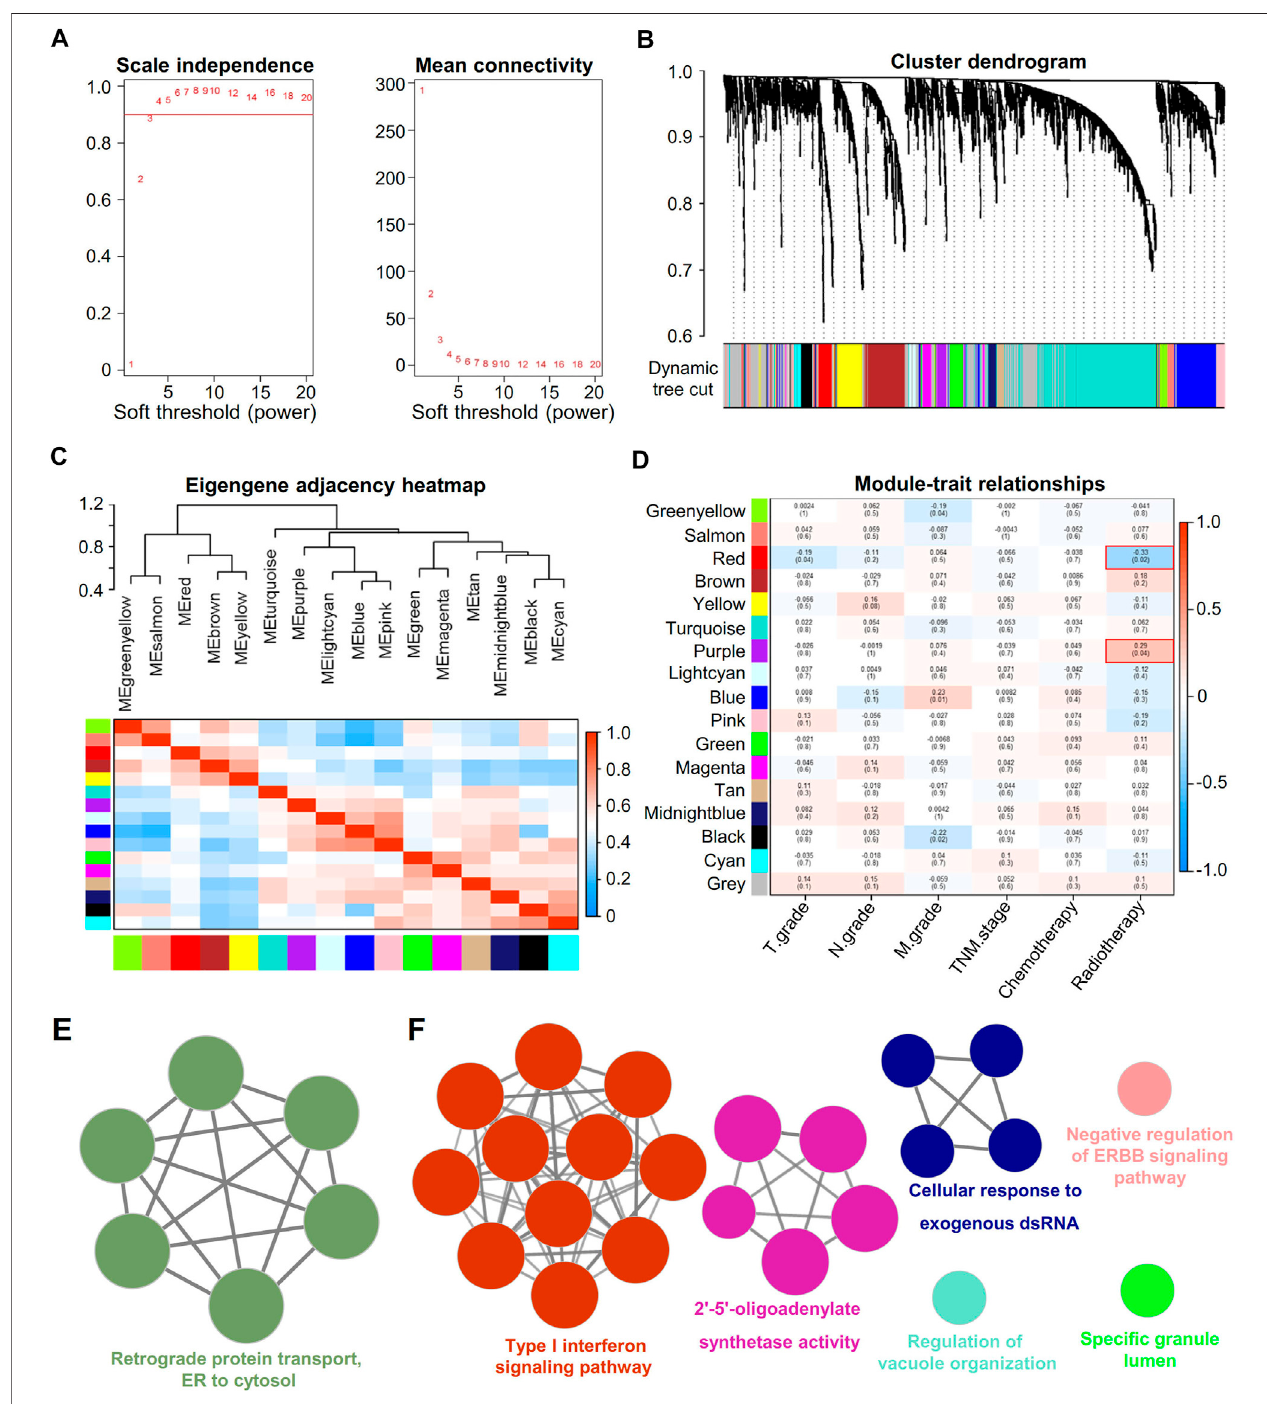
FIGURE 3 | Identi fi cation of key modules correlated with clinical traits in the TCGA-LUAD dataset with WGCNA and ClueGO. (A) Soft thresholding for WGCNA analysis. (B) Clustering dendrogram of genes based on topological overlap. (C) Clustering of module eigengenes. The heatmap shows the correlation of the adjacency module. (D) Heatmap of the correlation between module eigengenes and clinical traits of RT. (E) Enrichment analysis of the red module. Each node represents an enrichmentpathway. (F) Enrichmentanalysisofthepurplemodule.Eachnode representsanenrichmentpathway,and thecirclecolorindicatesdifferentfunctional